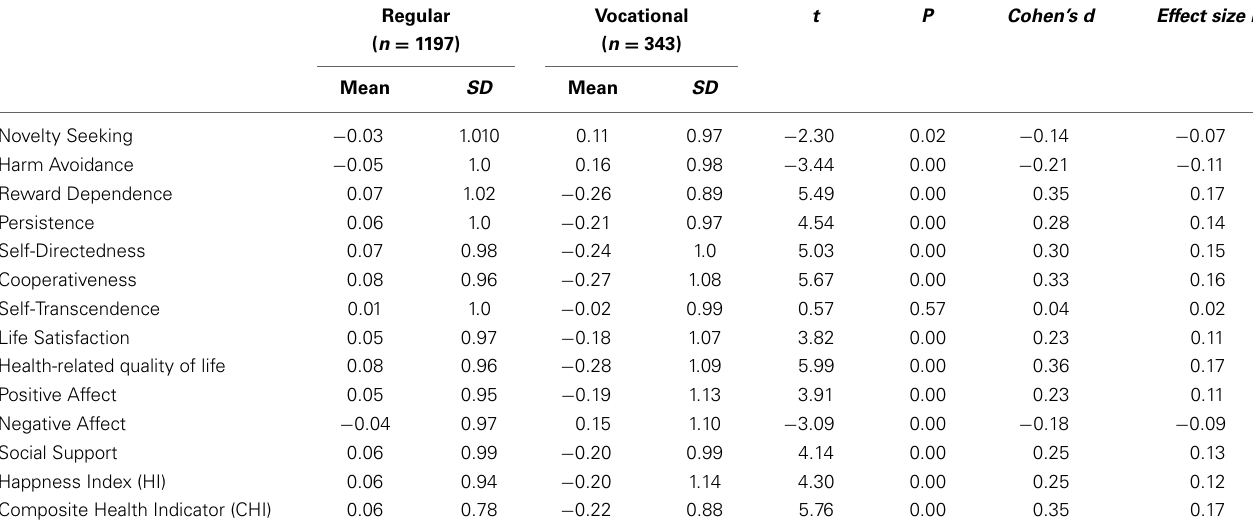
Table 3 | TCI dimensions (assessed by the JTCI and the TCI-R versions), measures of well-being, Happiness Index and Health Index by curriculum